Question: What direction does the quantity move in — increasing or decreasing?
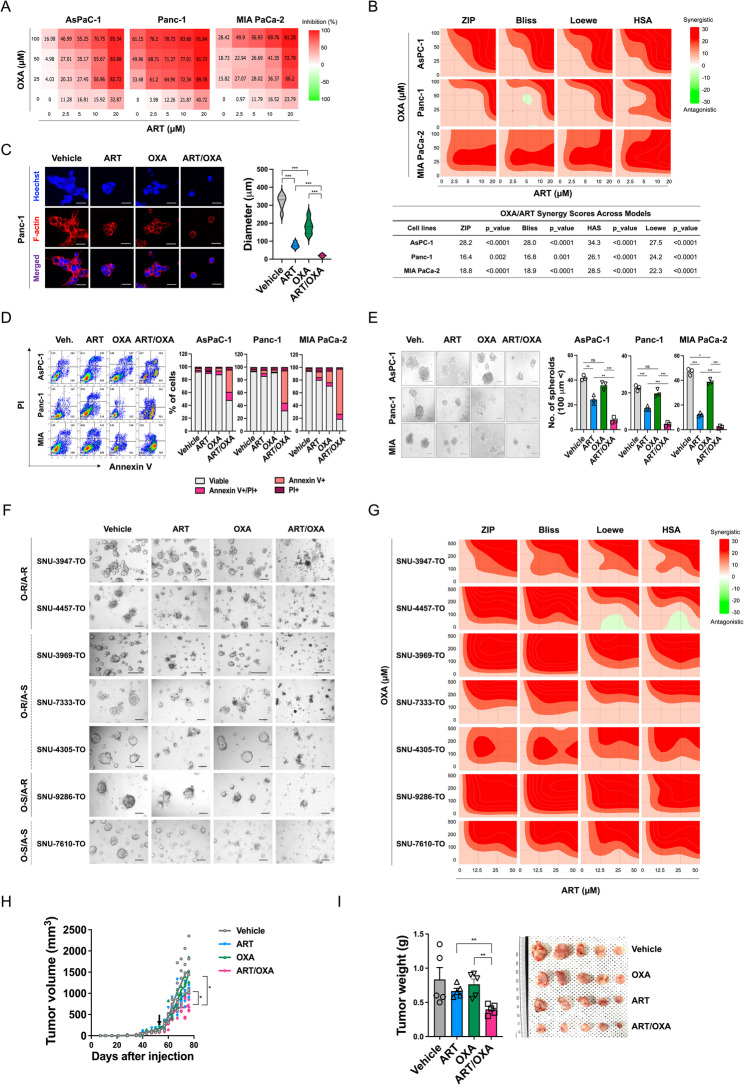
Answer: increasing